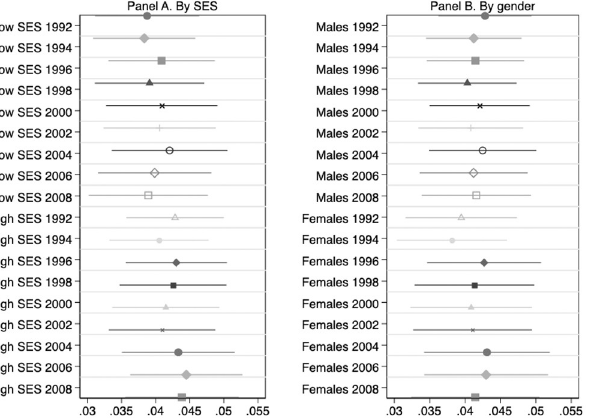
Fig 4. Association between BMI polygenic scores and Log(BMI) along the life-cycle: Patterns by gender and socioeconomic background. HRS Original Cohort . This Figure summarizes the results of estimating Eq 2 on the balanced sample of 3,181 HRS Original cohort members described in Table 1 by parental socioeconomic status (SES, in Panel A) and by gender (Panel B). The dependent variable is Log(BMI). OLS coefficient estimates of β 1 as well as their associated 95% confidence intervals are depicted. All regressions include age, age squared, and the first 10 principal components of the full matrix of genetic data. Regressions by SES (in Panel A) also include a female dummy as a covariate. Low and High SES individuals are those whose parental socioeconomic status is below and above the median, respectively. Standard errors are clustered at the household level.